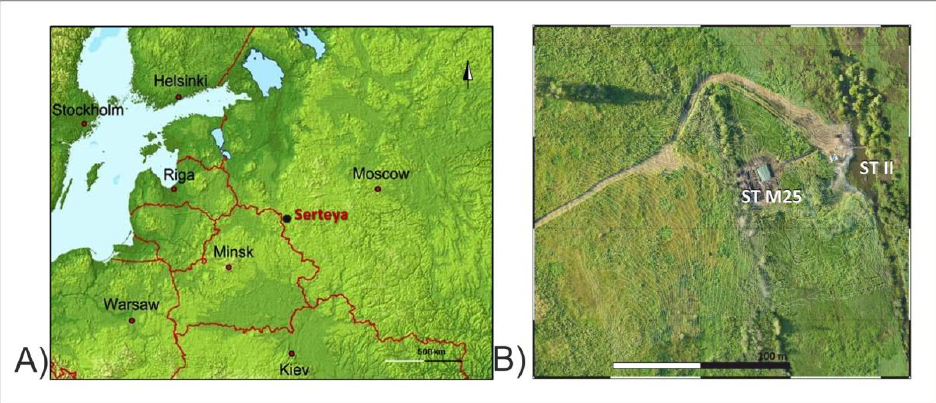
Figure 1. ( A ) Location of the study area; ( B ) location of the studied